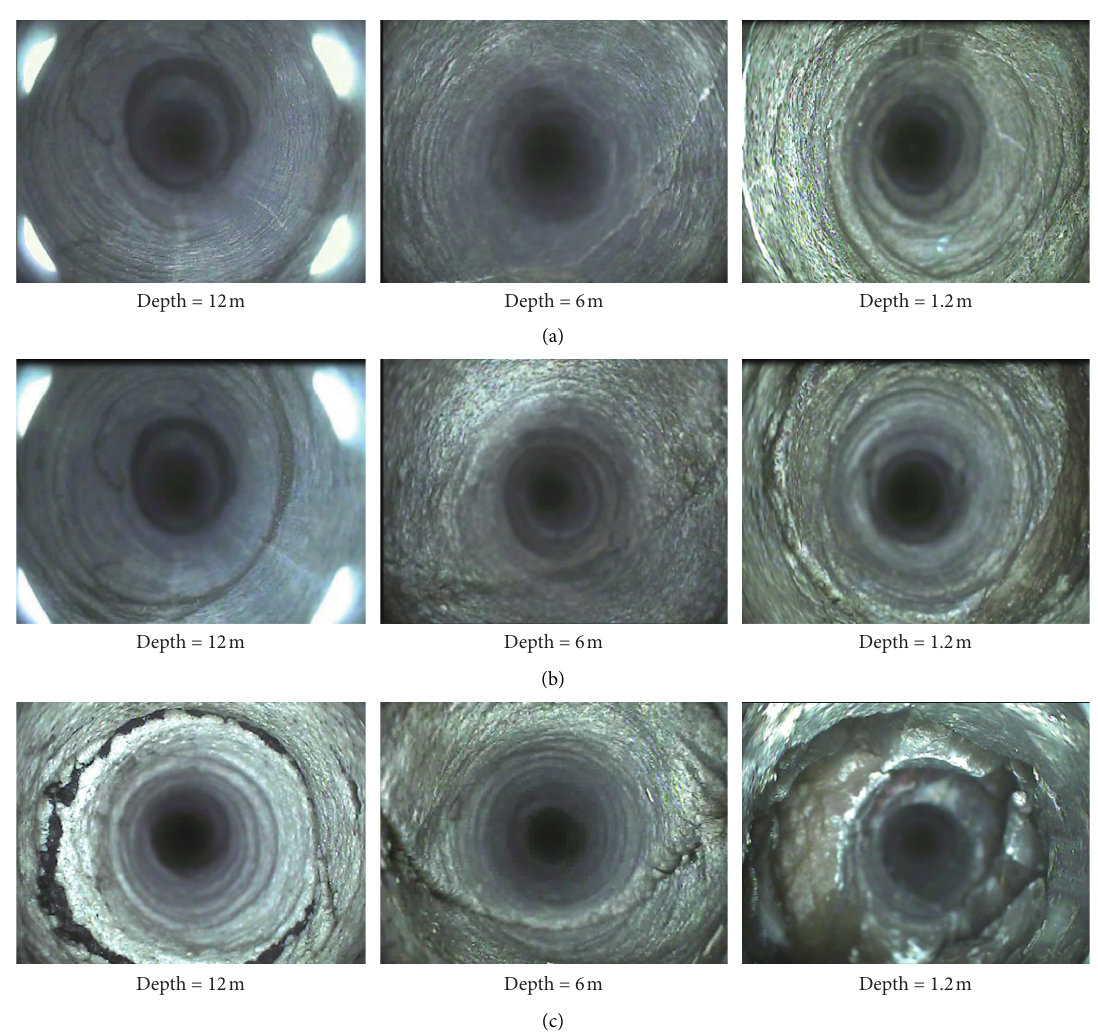
Figure 6: Fracture development in roof strata. (a) 50 m ahead of the face line. (b) 20m ahead of face the line. (c) 10m ahead of the face